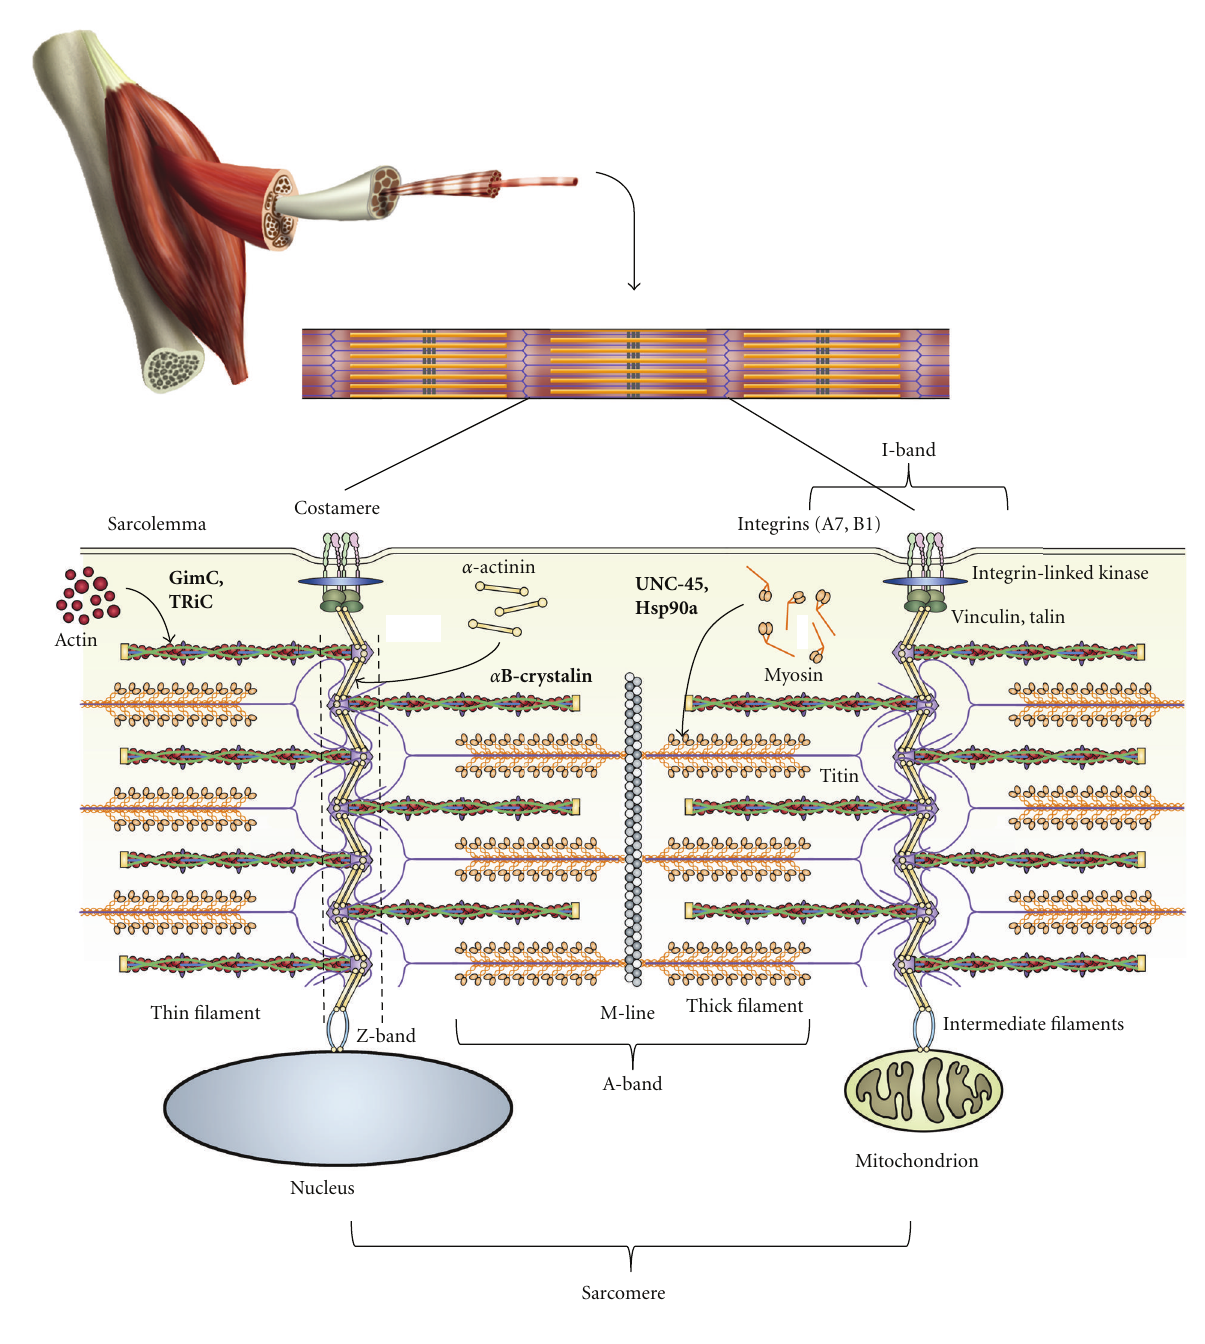
Figure 2: Schematic diagram of the sarcomere and costamere protein complexes of striated muscle cells. Major components of the mature sarcomere and costamere are shown, along with the cytoskeletal and motor filament systems, in context with the sarcolemma and organelles of syncytial myocytes. Known chaperone or cochaperone molecules are shown in bold, along with their substrates. Arrows indicate regions where chaperone-mediated protein folding is essential to incorporate polymeric filament proteins. Modified from Sparrow and Schock [17], additional artwork by A.